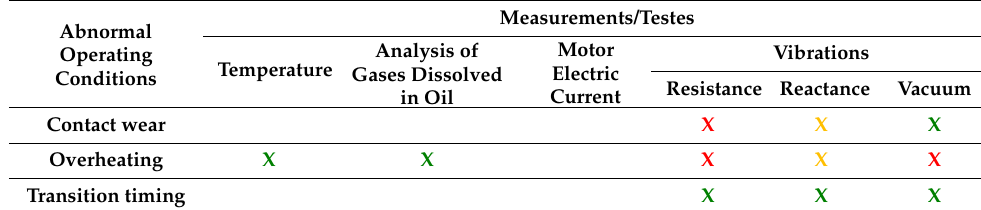
Table 17. Sensitivity of tests for detecting anomalies. Adapted from [22] and